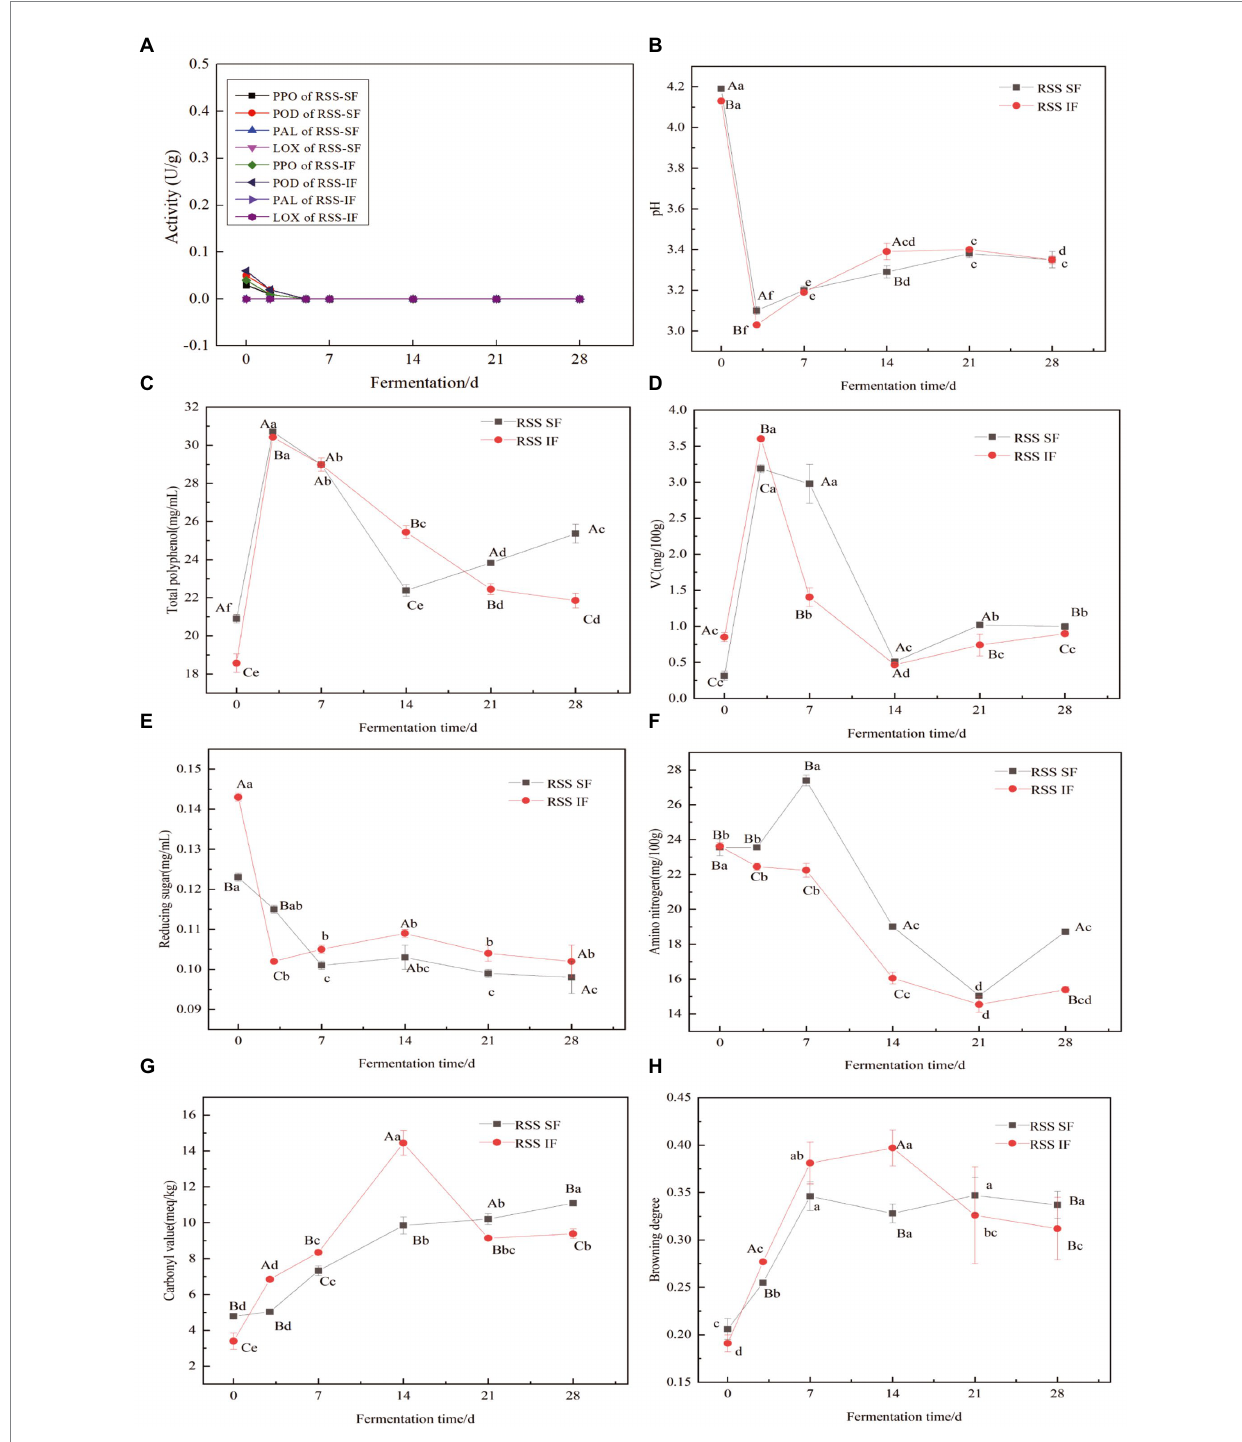
FIGURE 1 Changes of, PPO, POD, PAL, and LOX activity (A) , pH (B) , total polyphenol (C) , Vc (D) , reducing sugar (E) , amino nitrogen (F) , and carbonyl value (G) browning degree (H) of group RSS-SF (red sour soup with spontaneous fermentation) and RSS-IF (red sour soup with inoculant fermentation) during fermentation. Different capital letters represent significant differences at the same time and different groups, lower case letters indicate the difference is significant at same group and different fermentation time of p <